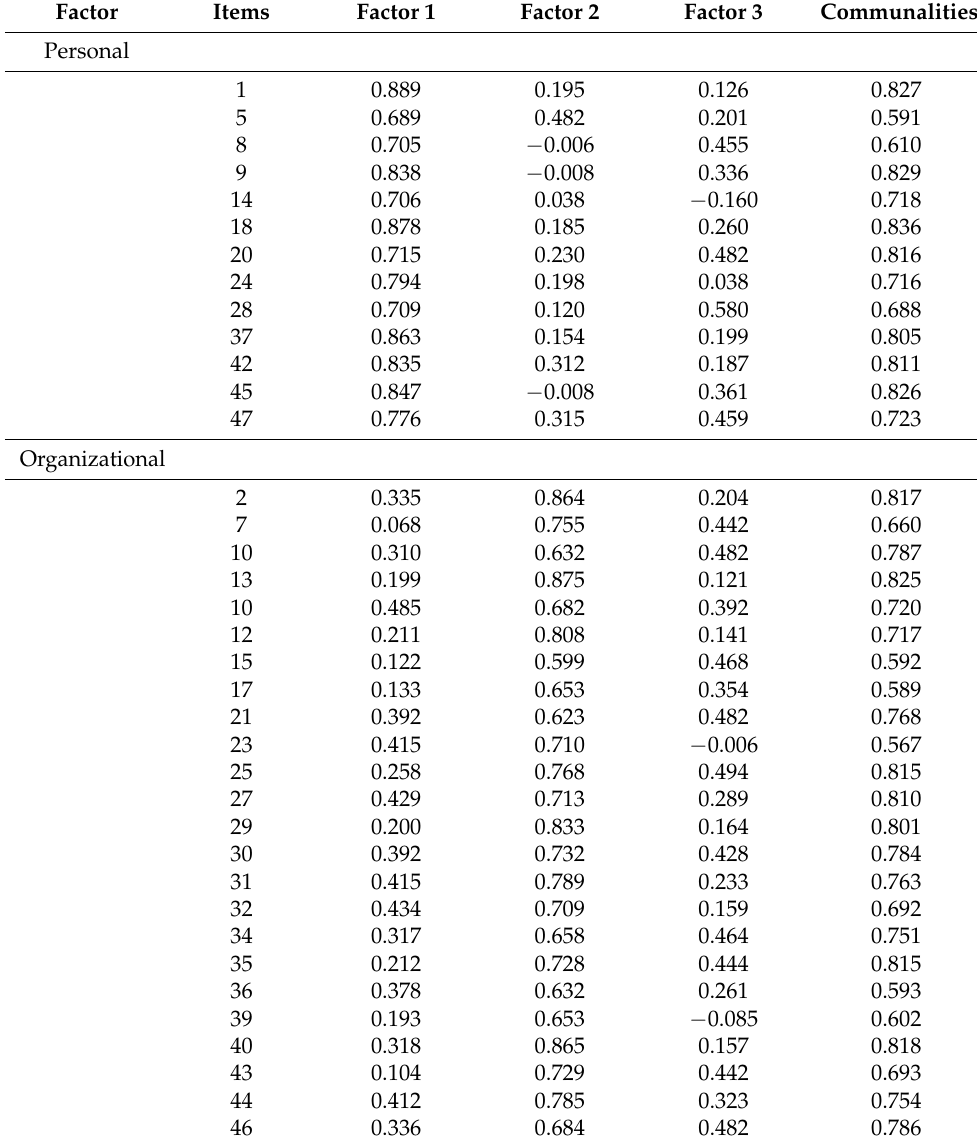
Table 2. Analysis of factor loadings, communality, eigenvalues and variance explained by total and each factor of scale ( n =